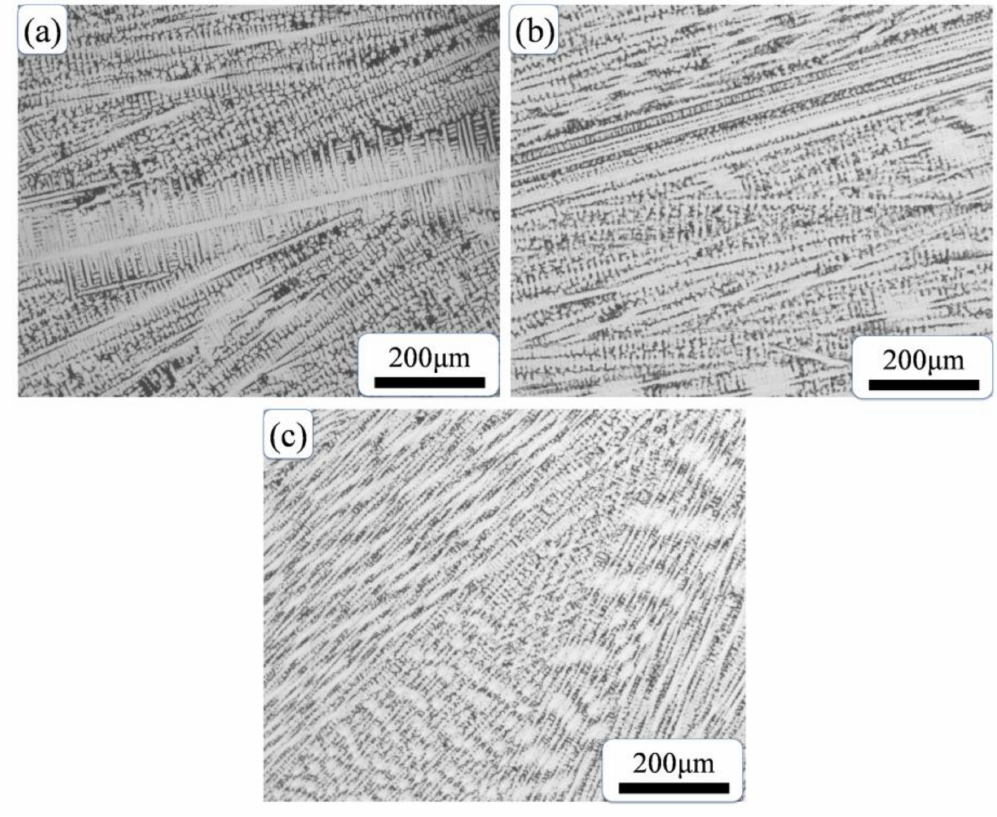
Figure 1. Optical micrographs of as-cast nickel-based alloys: ( a ) Ni-Nb1; ( b ) Ni-Nb3; ( c )